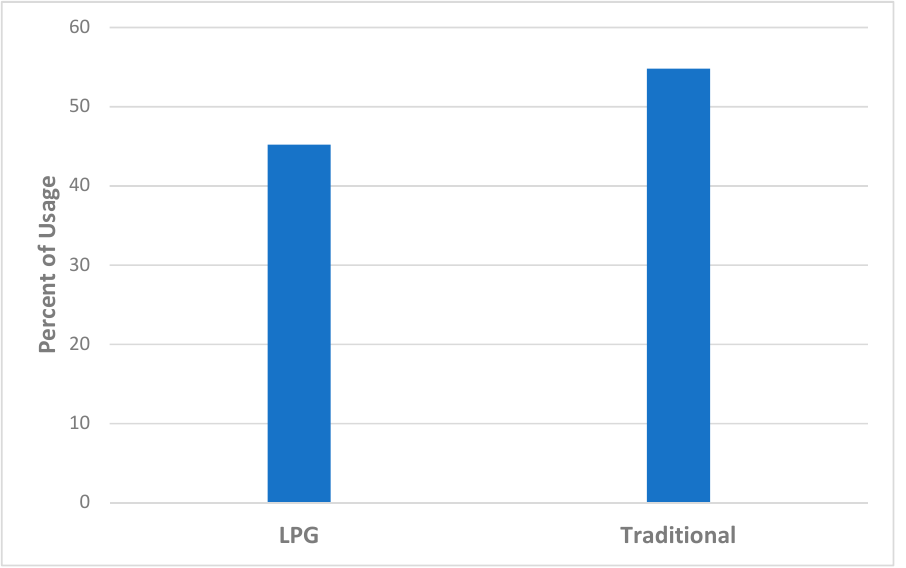
Figure 1. Percent average LPG and traditional stove use for all study households over 18 months of monitoring.